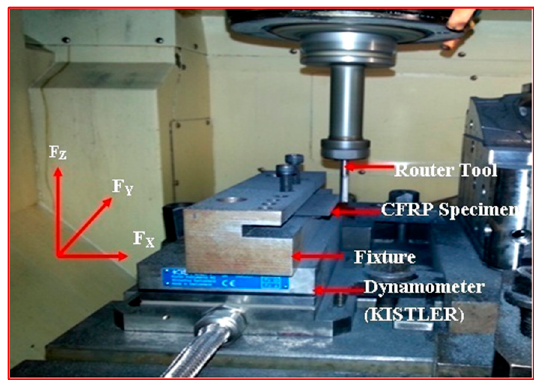
( c ) Figure 2. ( a ) Tool T1 ( b ) Tool T2 ( c ) Tool T3. Table 1. Cutting tools used and their specification. Tool Specification Image of the Tool Tooth Shape Tooth Profile Tool T1 Pitch = 3.42 mm No. of flutes—12 Tooth Shape—Trapezoidal Tool T2 Pitch = 2.42 mm No. of flutes—12 Tooth Shape—Pyramidal Tool T3 Helix angle 30° No. of. flutes—4 Tooth Shape—Helical fluted